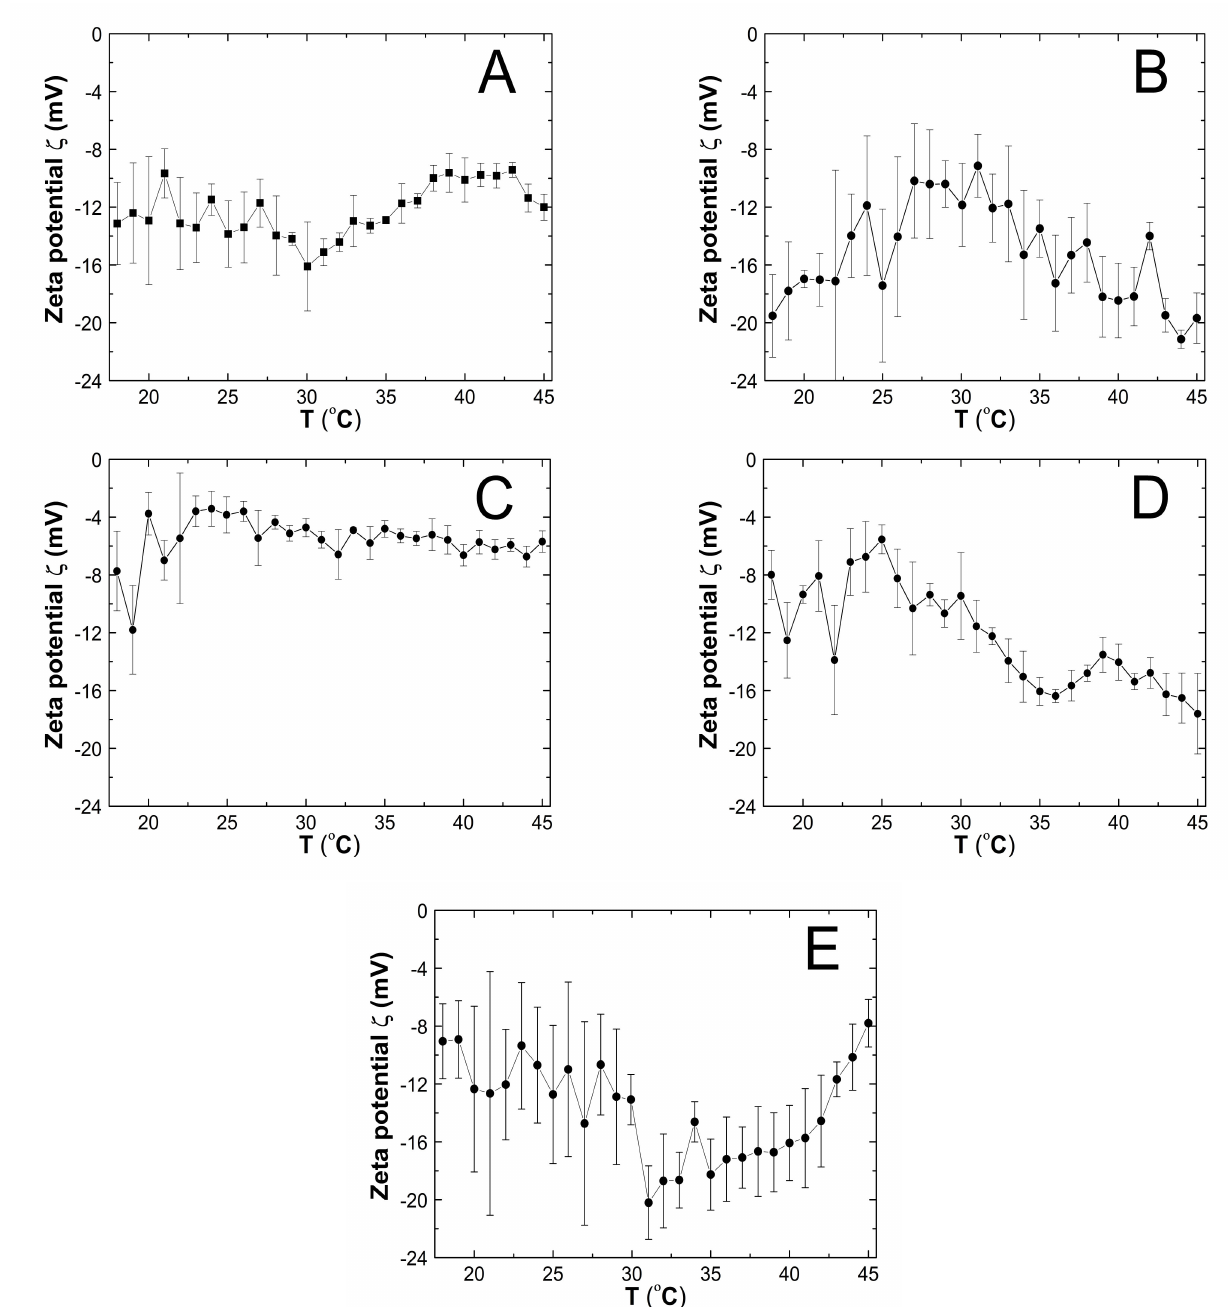
Figure 11. ( A – E ) The influence of temperature on zeta potential (ZP) of the PS1 ( A ), PS2 ( B ), PS3 ( C ), PS4 ( D ), and PS5 ( E ) samples, determined by electrophoretic